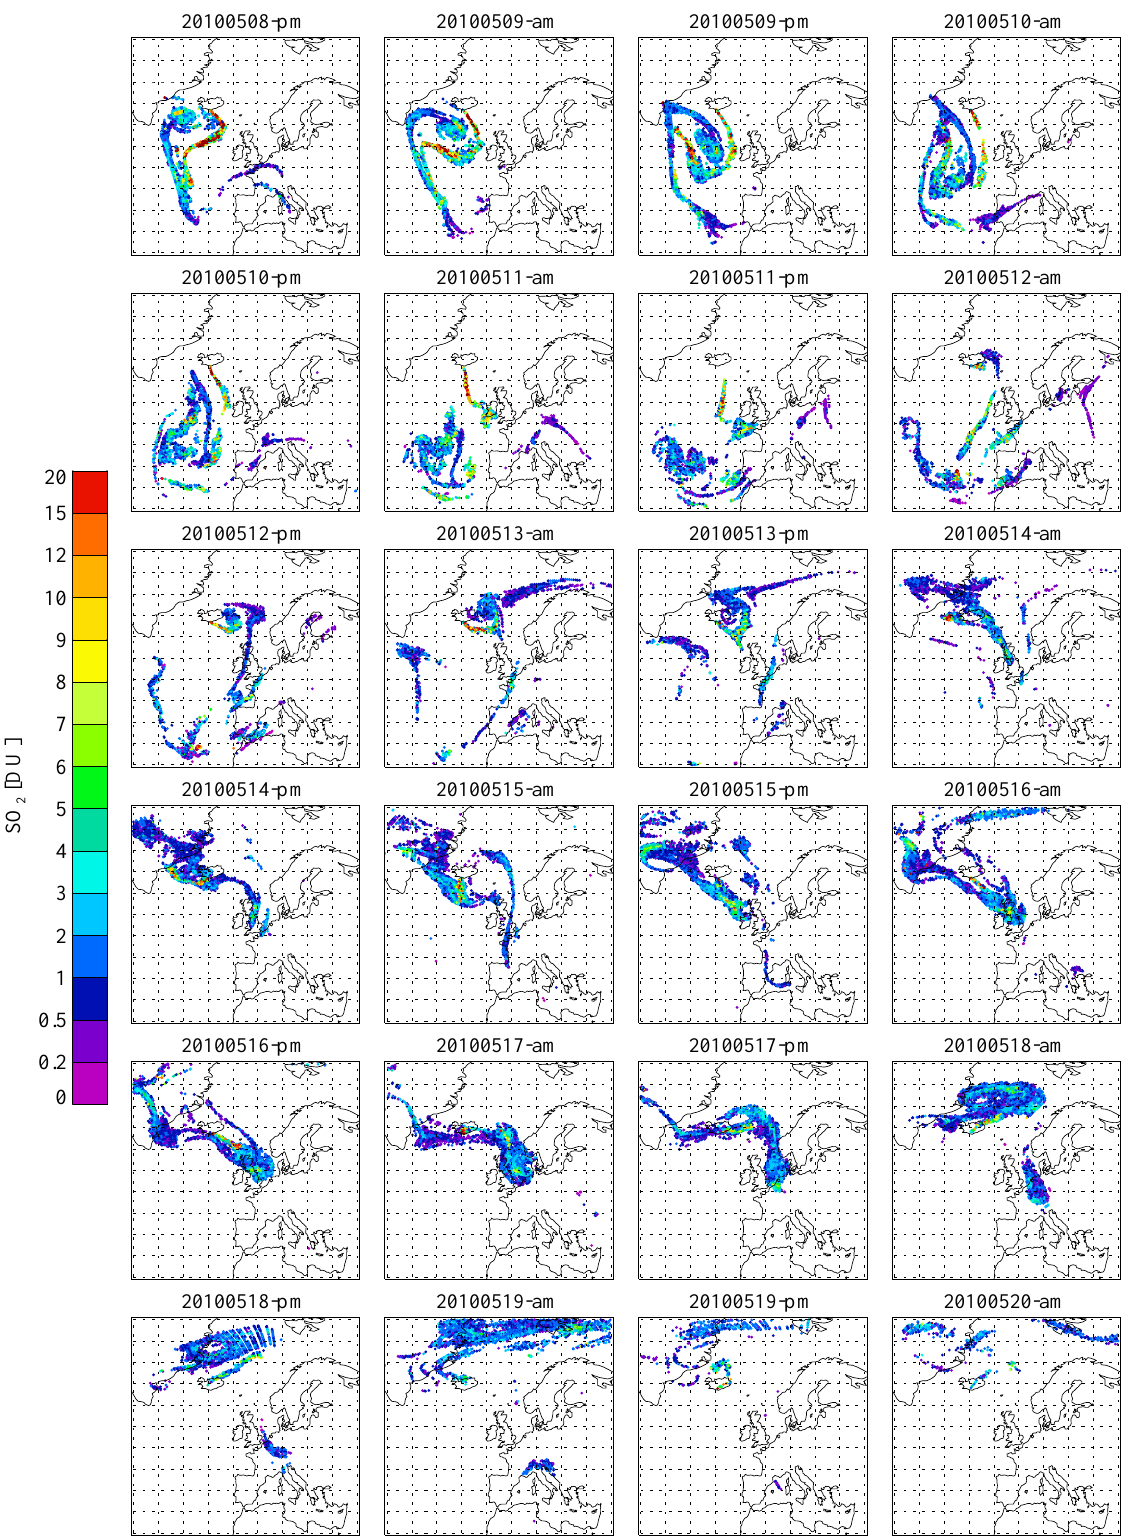
Fig. 9. IASI SO 2 column amount, divided into morning and afternoon orbits, for the period from 8 to 17 May 2010.